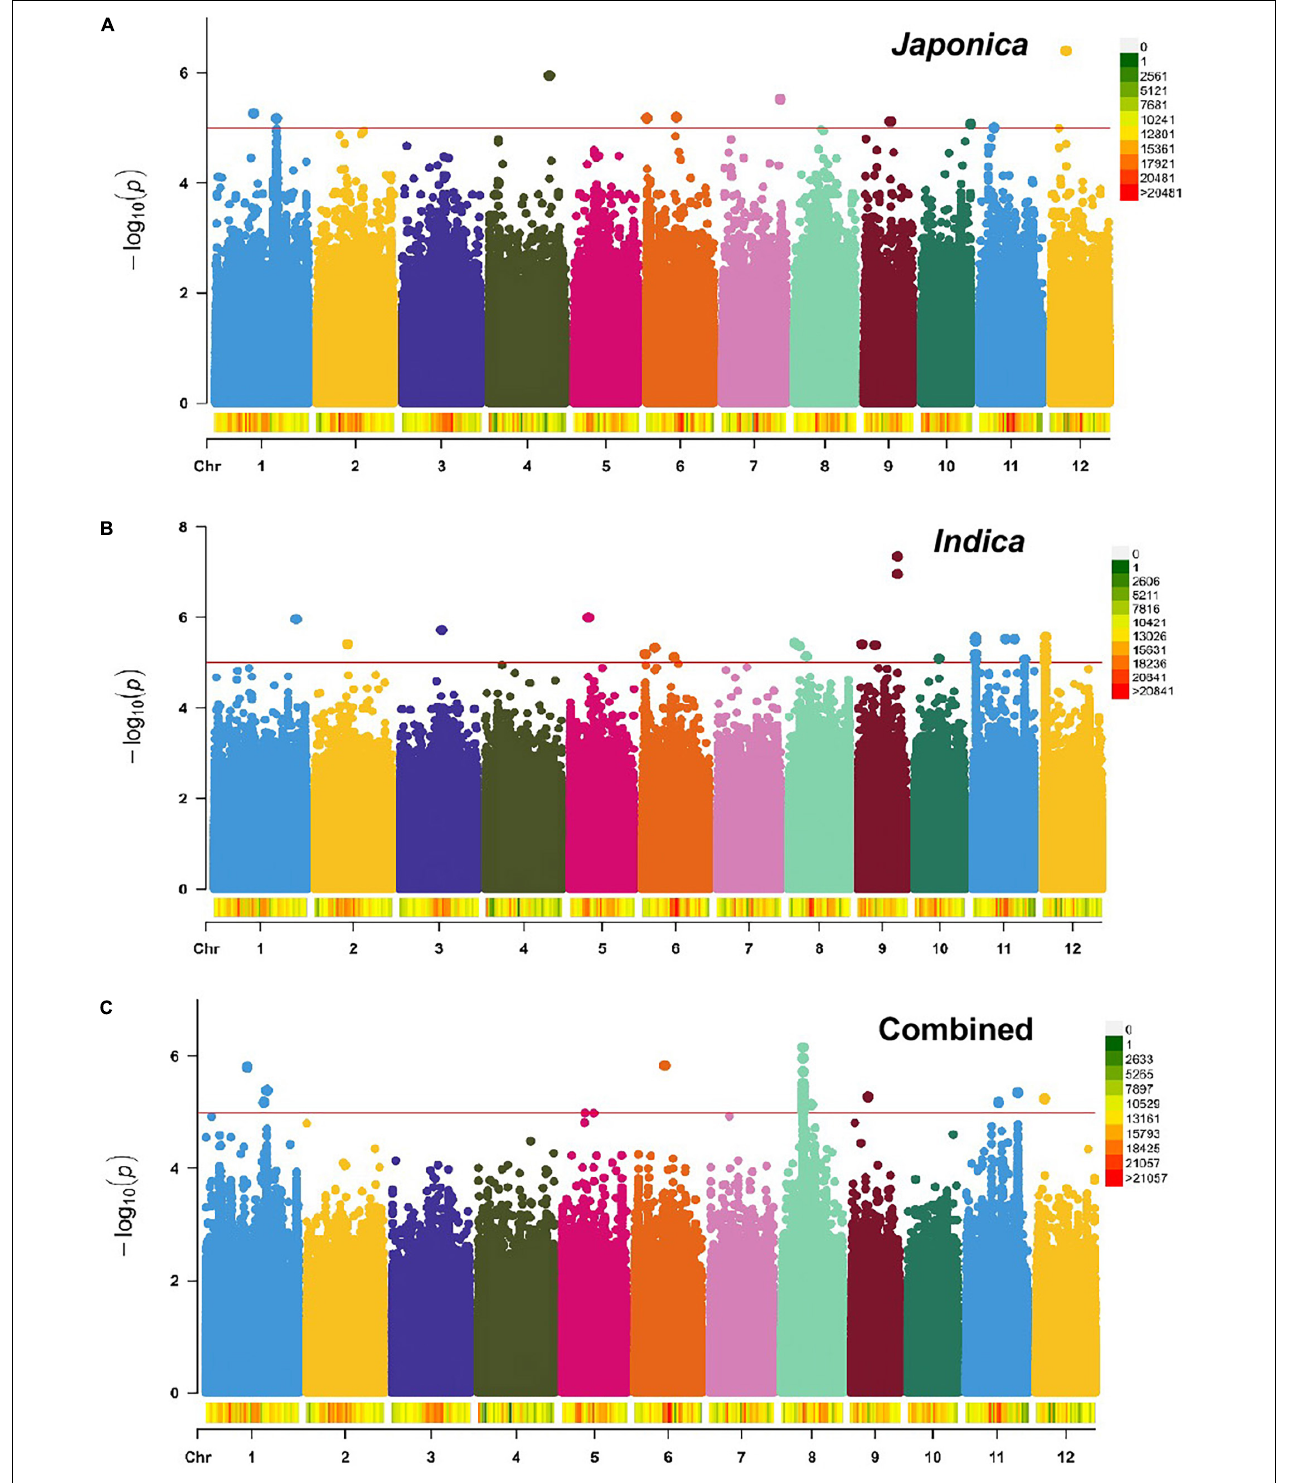
FIGURE 6 | Manhattan plots showing genome-wide SNPs associated with NSP in the Japonica (A) , Indica (B) , and Combined (C) populations, respectively, under HNT stress across the rice genomes. The red line represents the association threshold –log 10 p ≥ 1e–05. The right-hand side scale of each plot indicates the distribution of genome-wide SNPs across the rice genomes that were used in this study.